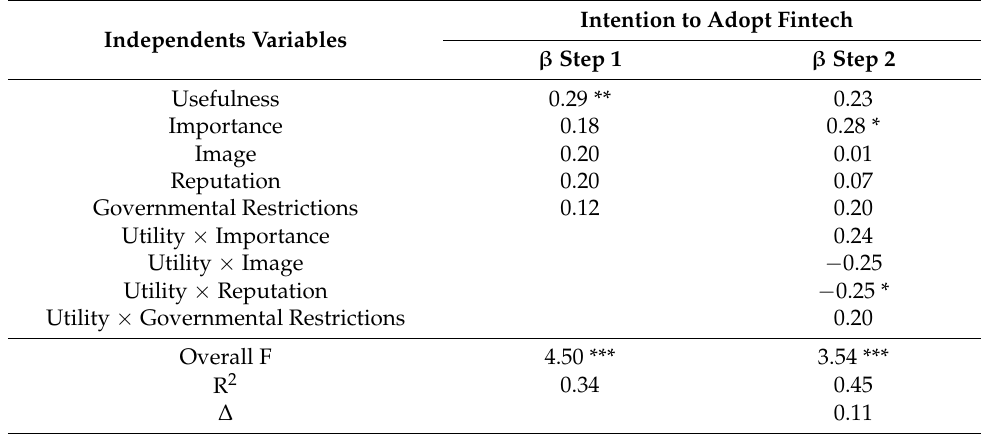
Table 9. Moderating effect of environmental context on the relationship between perceived usefulness of Fintech services and intention to adopt Fintech services (Source—IBM SPSS Statistics v.28.0.0).